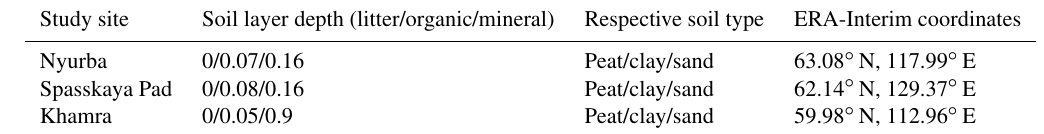
Table 3. Study site parameters for CryoGrid.